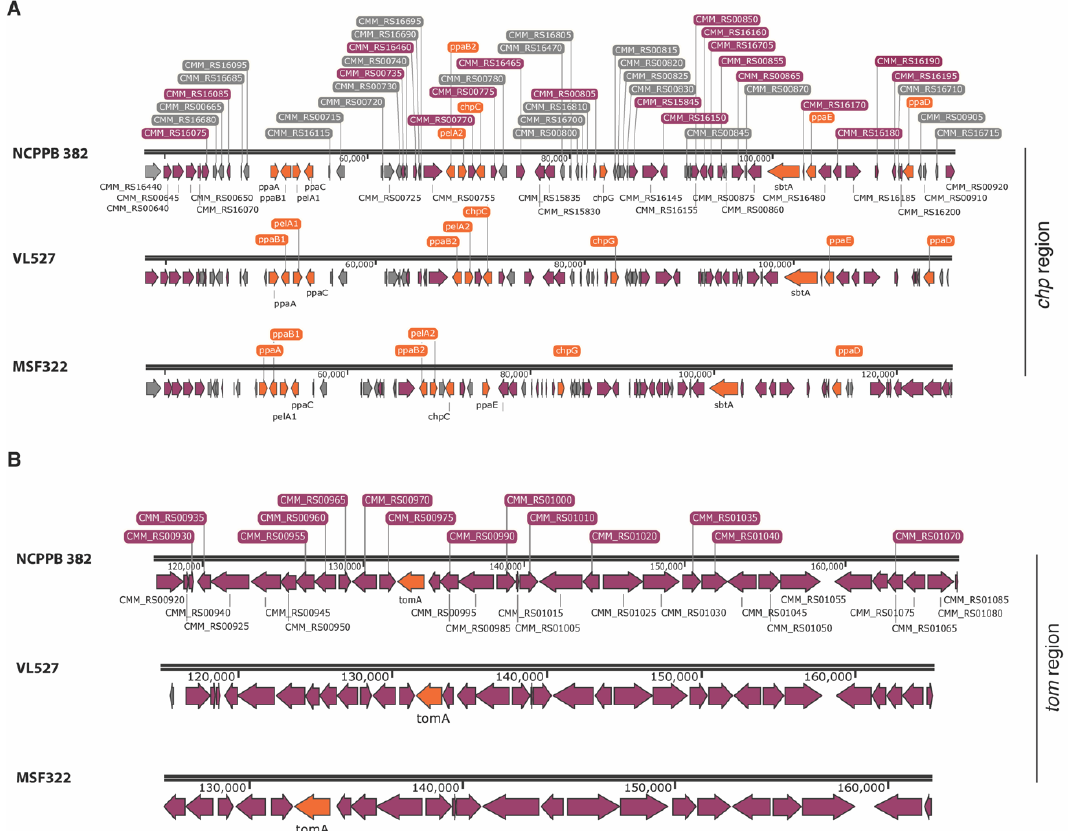
Figure 3. Schematic representation of the pathogenicity regions of the Chilean strains VL527 and MSF322. The chp ( A ) and tom regions ( B ) of C. michiganensis subsp. michiganensis strains NCPBB 382, VL527 and MSF322 are shown. The virulence genes (e.g., pelA , chpC , chpG , ppaA—ppaE , sbtA , tomaA ) are represented in orange. The genes with other functions are depicted in purple and hypothetical genes are illustrated in grey.